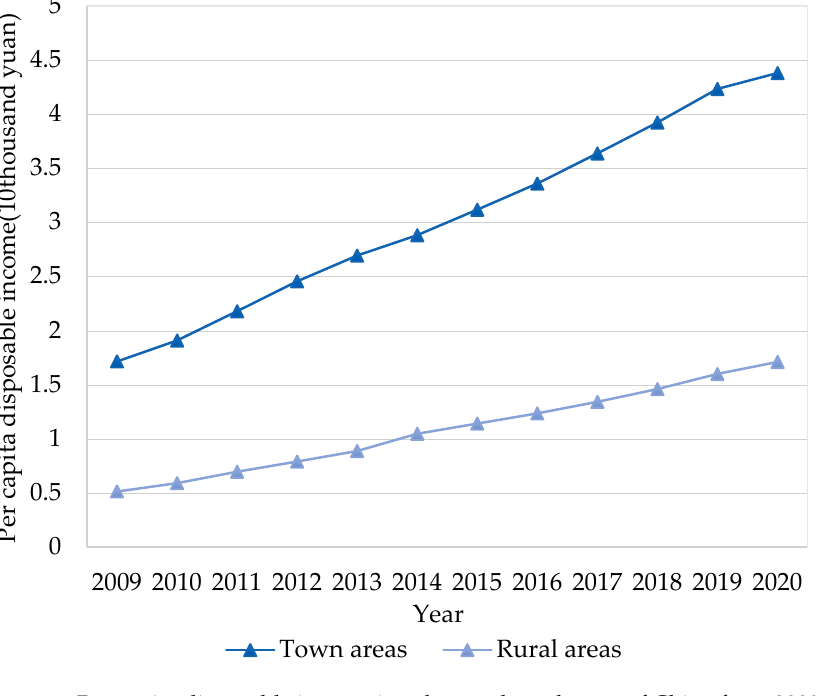
Figure 1. Per capita disposable income in urban and rural areas of China from 2009 to 2020. Note: Data from China Statistical Yearbook.